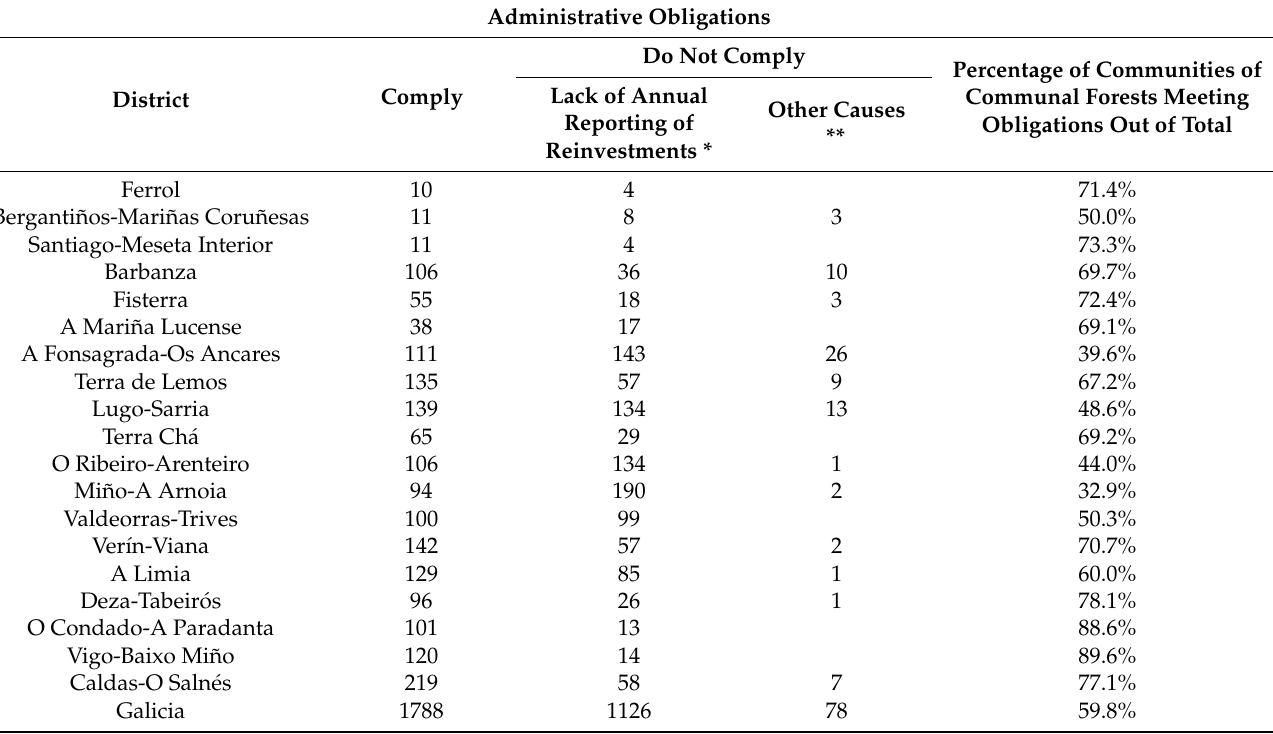
Table 4. CCFs by administrative status,